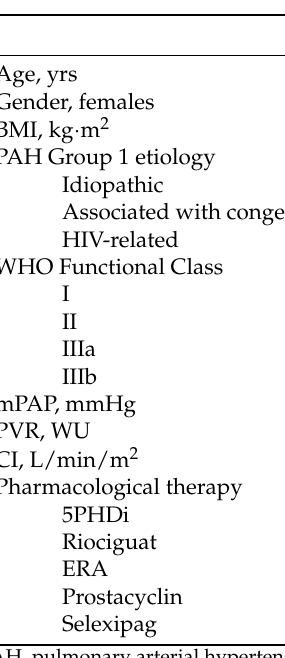
Table 1. Demographic and clinical characteristics of the enrolled samples.